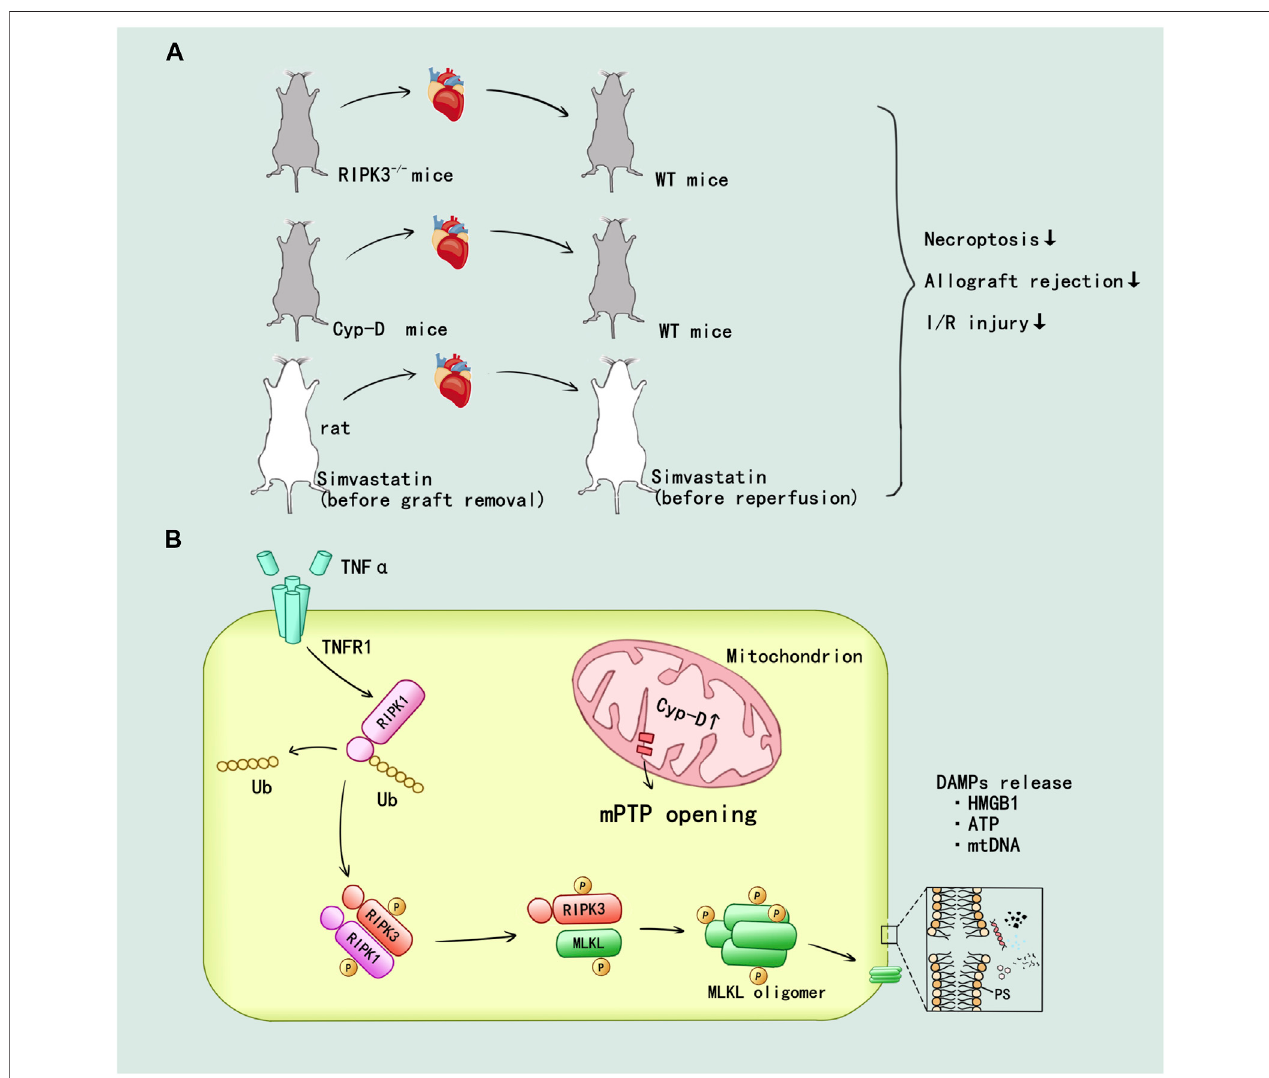
FIGURE 5 | RIPK1/3-mediated necroptosis promoted the in fl ammatory and I/R injury in heart transplant. (A) In vivo , the establishment of RIPK3 and Cyp-D knockouthavebeenveri fi edthatinhibitionofRIPK3 andmitochondrialpathway couldalleviate theinjury.Thesimvastatin pretreatmentindonorandrecipientattenuated the allograft rejection and I/R injury. (B) TNF- α can promote the deubiquitination of RIPK1 through TNFR1 mediated intracellular signal transduction. mPTP opening mediated by Cyp-D facilitate the formation of RIPK1/RIPK3/MLKL necrosome and MLKL phosphorylation. Then, MLKL ultimately mediated the cell membrane rupture and released a variety of